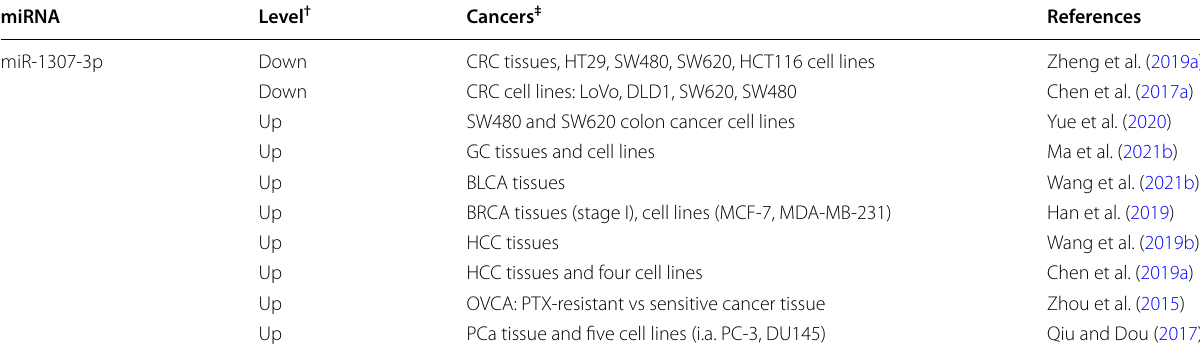
† , ‡ For description see footnote to Table 2